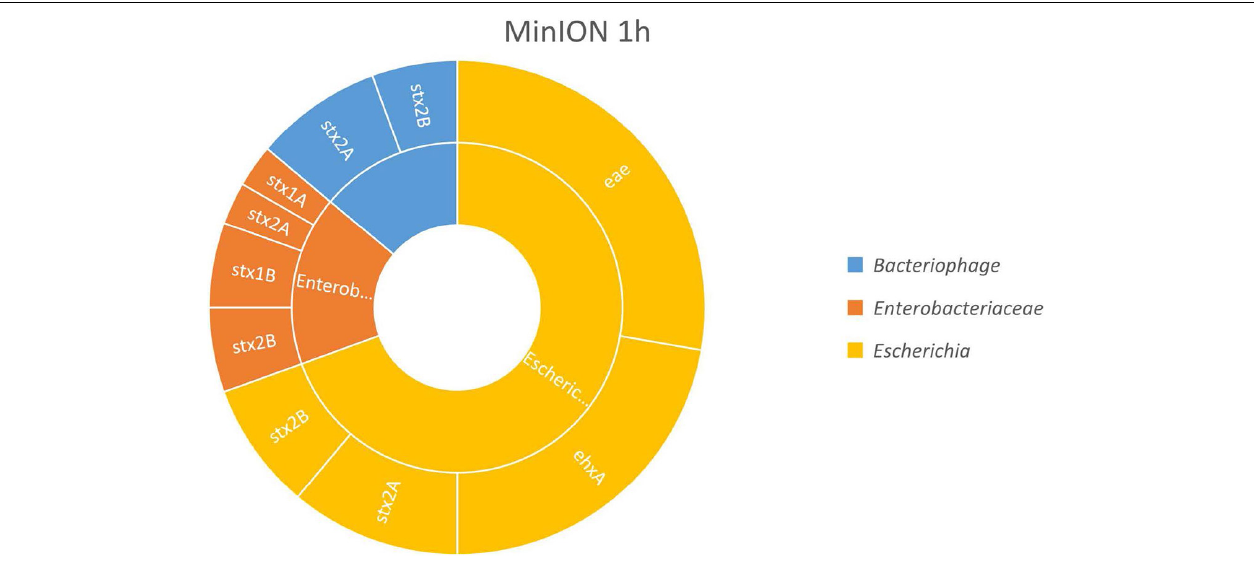
FIGURE 2 | In silico DNA walking results, presenting the genera in the inner circle (following the color scheme specified in the legend) and the genes detected for each taxon in the outer circle for MinION sequencing of the Shiga toxin-producing E. coli (STEC)-spiked beef sample after 1 h of